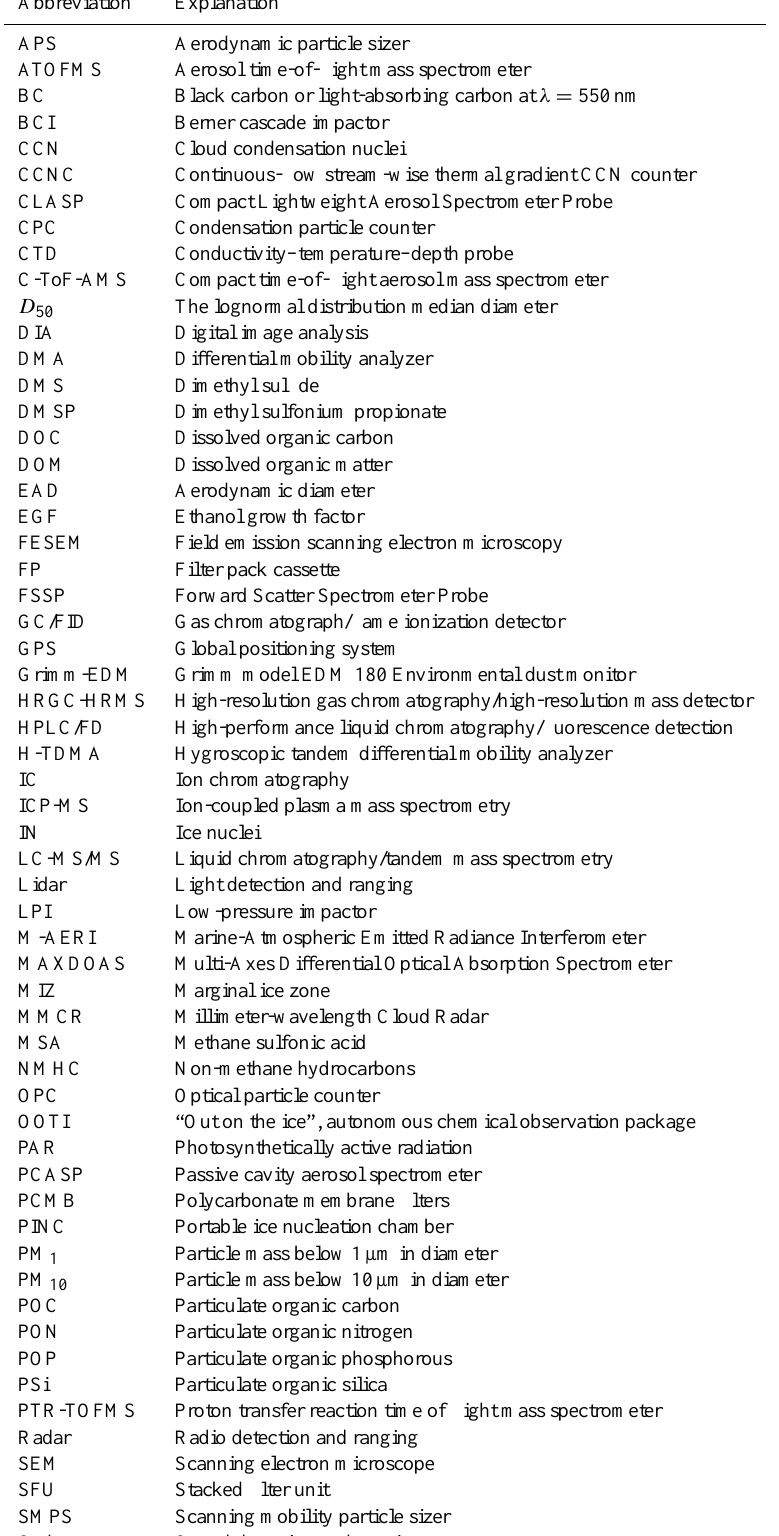
Table 1. List of